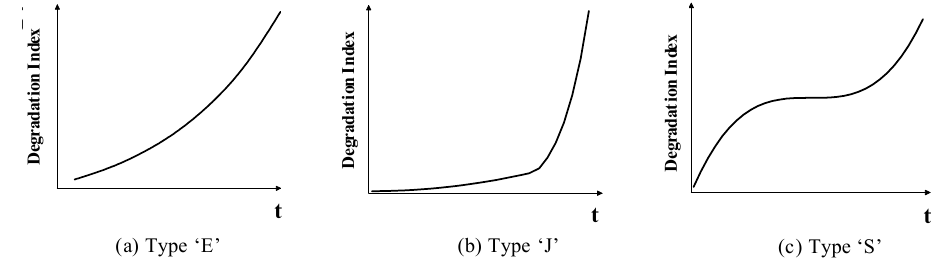
Figure 7. Three typical mechanical degradation curves.